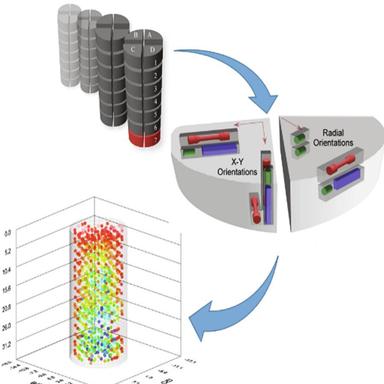
X-ray computer tomography (CT) image of extruded PCEA grade graphite illustrating an elongated pore structure oriented in the with-grain extrusion direction.